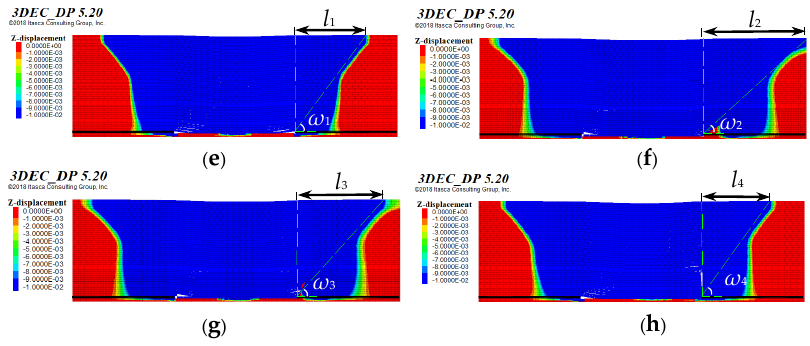
Plan I Surface movement boundary under different weak planes heights.